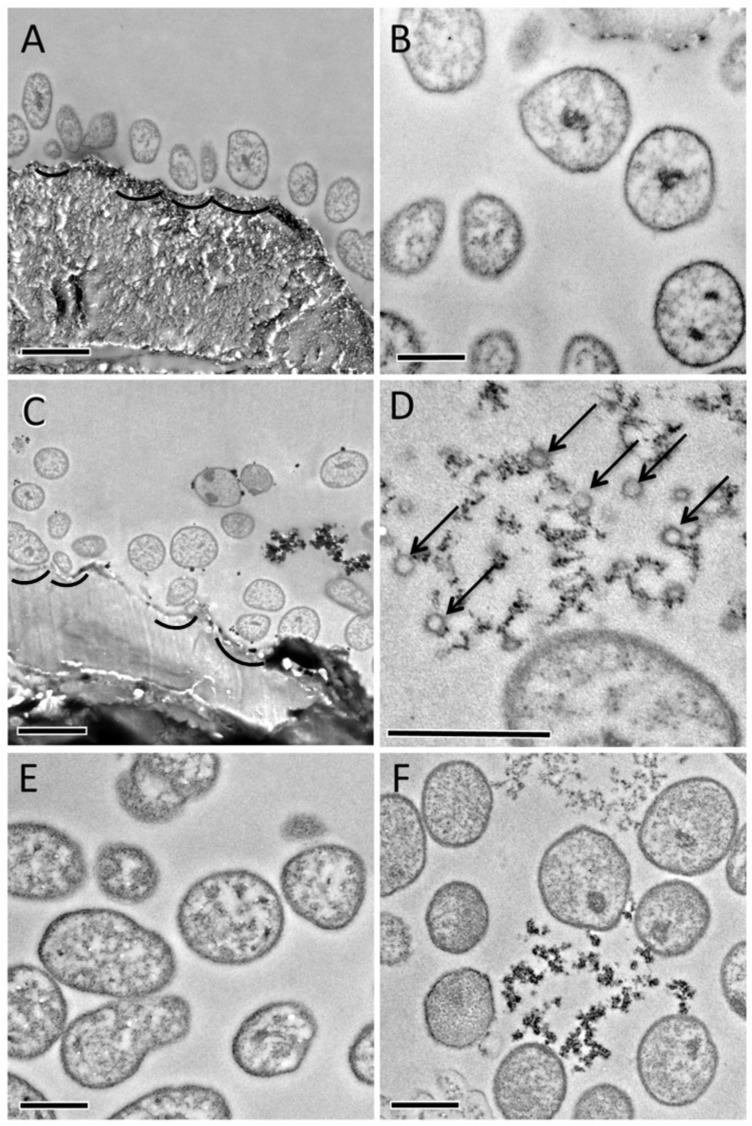
TEM images of F. succinogenes S85 harvested during mid-exponential growth on cellulose (A, B), cellulose stationary growth (C, D), glucose mid-exponential growth (E) and glucose stationary growth (F).Grooves in the cellulose were observed in the cellulose mid-exponential and stationary phases. Vesicles were present in only the cellulose stationary phase (arrows in D). Scale bars are 1 μm (A,C) and 0.5 μm (B-F). Vesicles are indicated by arrows. Grooves are indicated by curves.